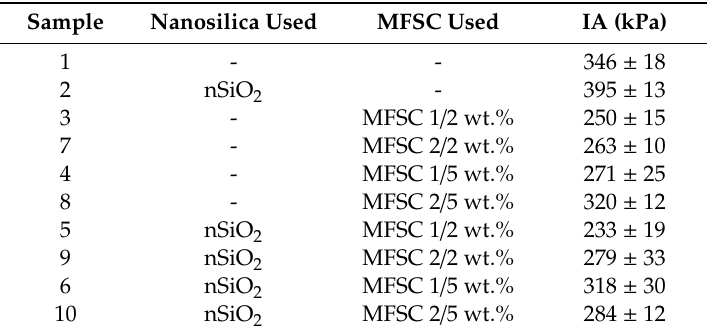
Table 4. The ice adhesion of fabricated